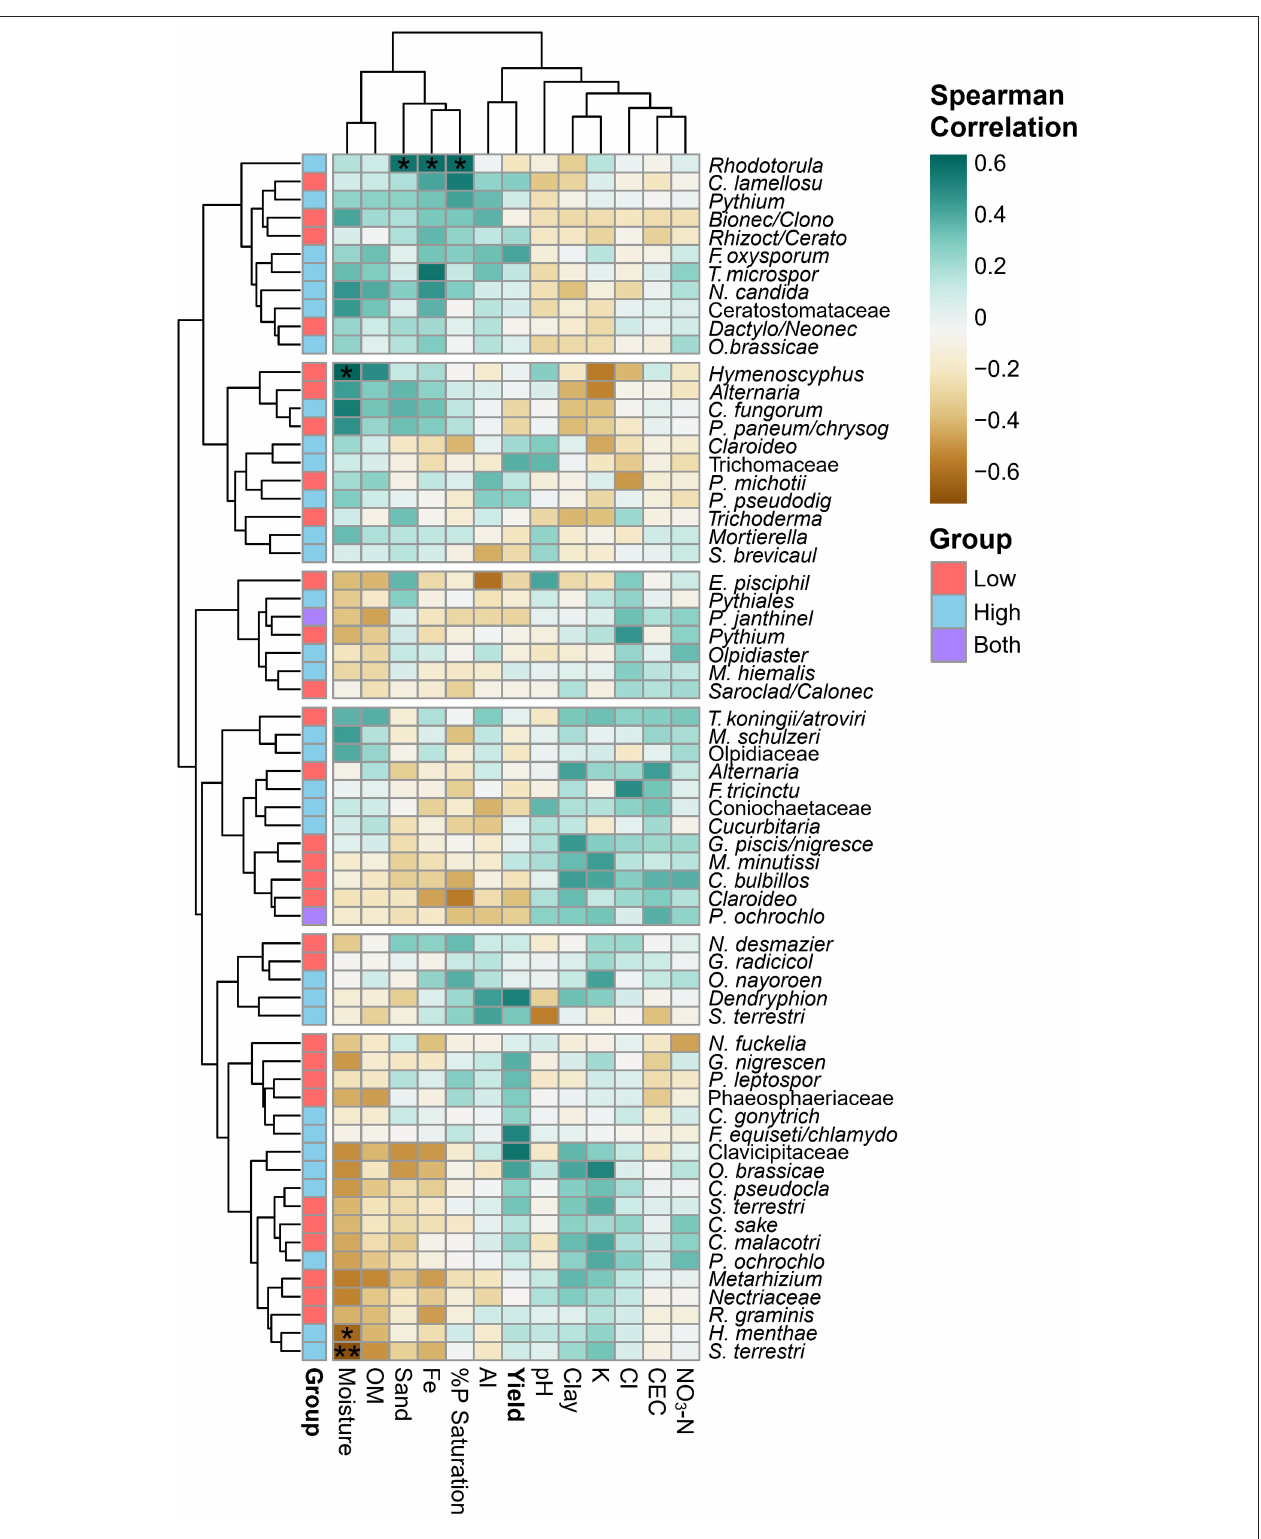
FIGURE 9 | Clustered heatmap of Spearman correlation coefficients between ecologically important indicator taxa (ALDEx) and key soil variables found in this study. Significant Benjamini–Hochberg adjusted p -values are shown with asterisks: * p < 0.05 and ** p < 0.01. Top (soil physicochemistry) and left (ALDEx taxa) dendrograms cluster similar factors using the complete linkage